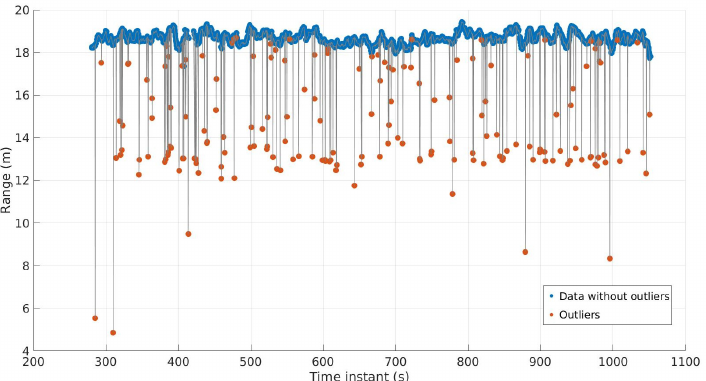
Figure 4. Range measurements observed between a static UWB anchor and a hovering